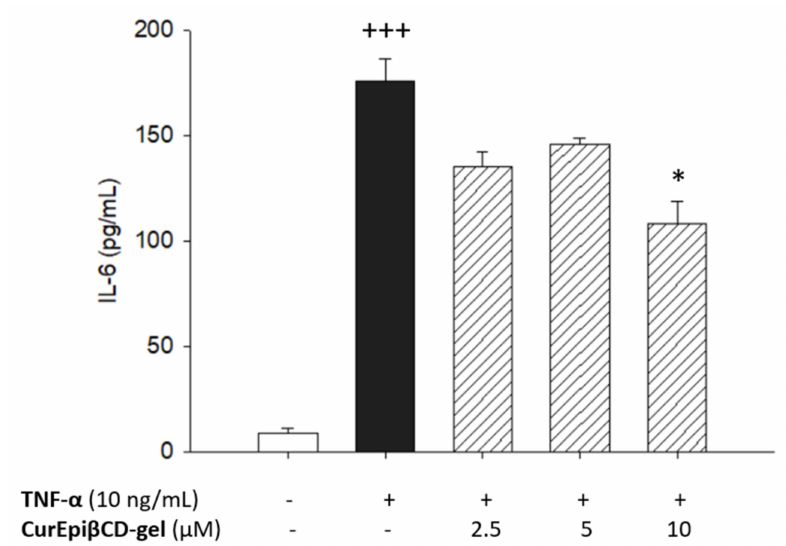
Figure 8. Effects of CurEpi β CD-Gel (2.5, 5 and 10 µ M) on interleukin (IL)-6 levels in TNF- α - stimulated HaCaT keratinocytes. Production of IL-6 in supernatant was measured by ELISA assay. Results are representative of six independent experiments. Data are expressed as the mean ± SEM. The mean value was significantly different compared with the control group (+++ p < 0.001; Student’s t -test). Mean value was significantly different compared with the TNF- α group (* p < 0.05; one-way ANOVA followed by Bonferroni’s Multiple Comparison